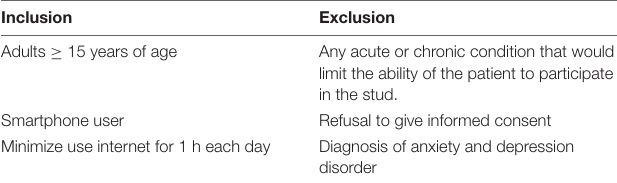
TABLE 1 | Inclusion and exclusion